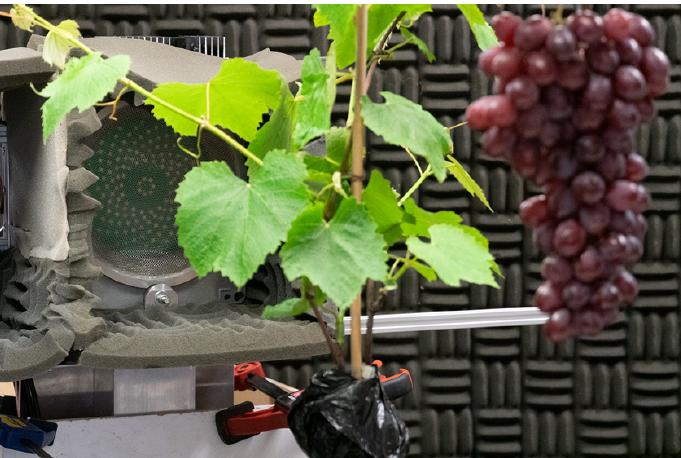
Figure 6. Photo showing the experimental setup with the grapes located behind a vine that is attached to a Computer Numerical Controlled (CNC)